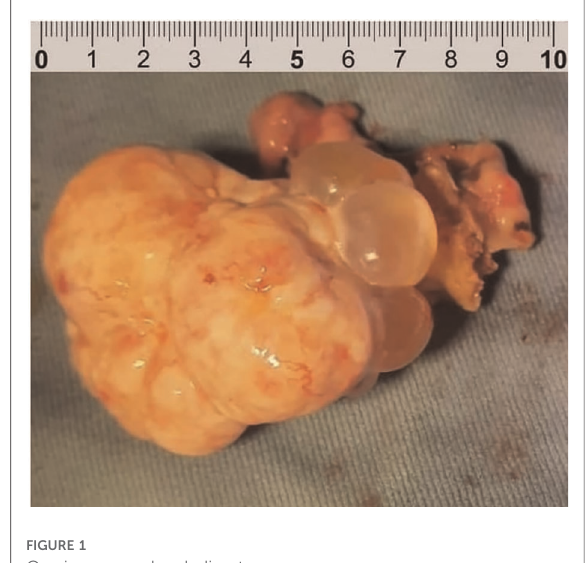
FIGURE 1 Ovarian serous borderline